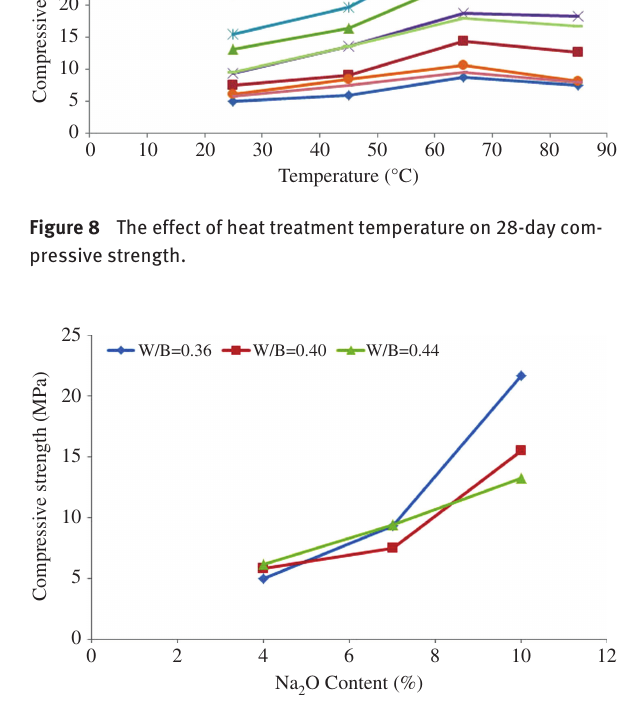
O on 28-day compressive strength for Figure 6 The effect of Na 2 samples cured at 65 ° C and constant MS.